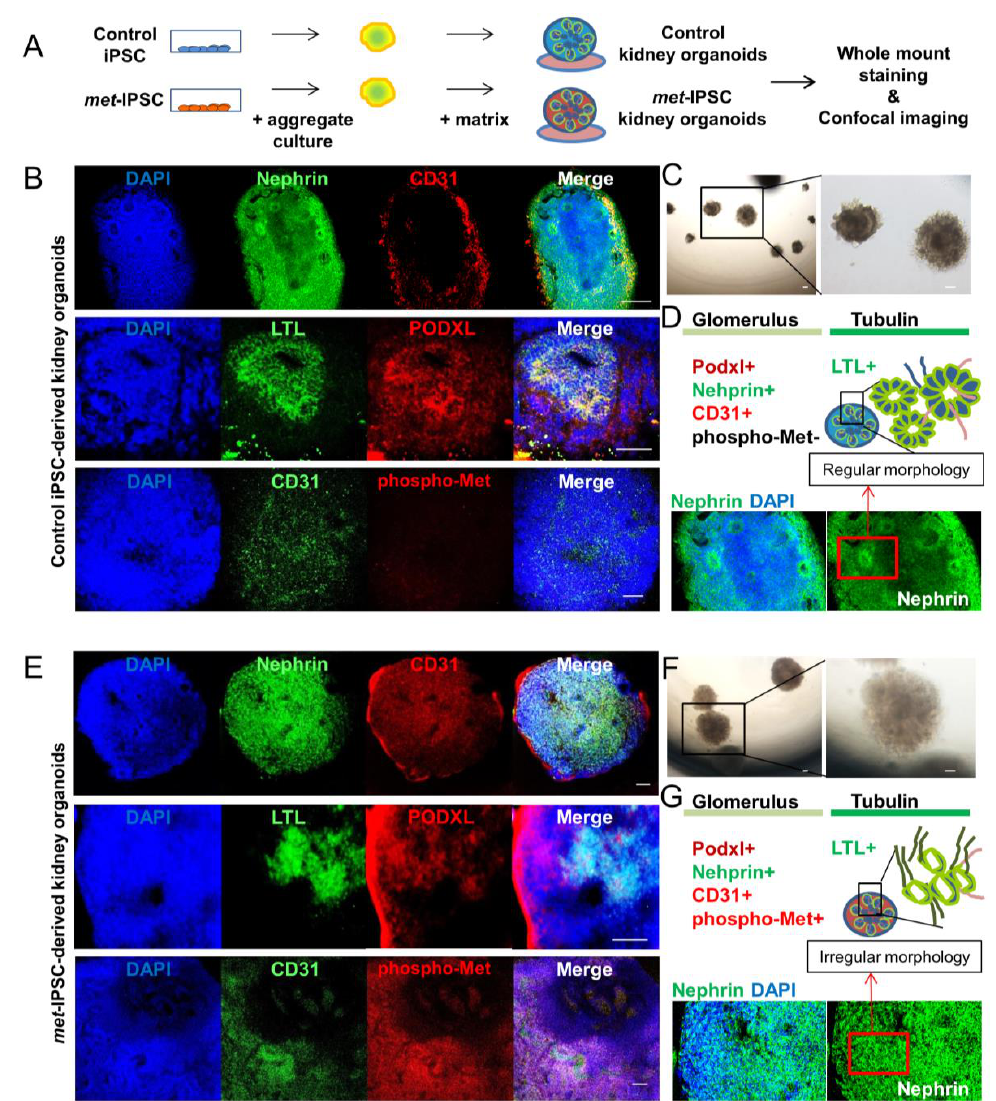
Figure 1. Embryoid bodies with kidney markers from control or met -IPSC in 3D culture. ( A ) Schematic representation of the generation of iPSC-derived structures from control or met -IPSC. ( B ) Confocal analysis and whole-mount immunostaining for Nephrin, CD31, LTL, PODXL, phospho-Met, and DAPI in control iPSC-derived kidney embryoid bodies showing nephron structure. Scale bar: 100 μm. ( C ) Optical image of control iPSC-derived kidney embryoid bodies at day 12 showing the formation of tubule structures. Scale bar: 100 μm. ( D ) Schematic representation of glomerulus and tubule markers with nephron structure. ( E ) Confocal analysis and whole-mount immunostaining for Nephrin, CD31, LTL, PODXL, phospho-Met, and DAPI in met -IPSC-derived kidney embryoid bodies. Scale bar: 100 μm. ( F ) Optical image of met -IPSC-derived embryoid bodies at day 12 showing the formation of tubule structures. Scale bar: 100 μm. ( G ) Schematic representation of glomerulus and tubule markers with nephron structure. Note: The met -IPSC-derived vesicles ( E ) present an irregular morphology as compared to controls ( B ).